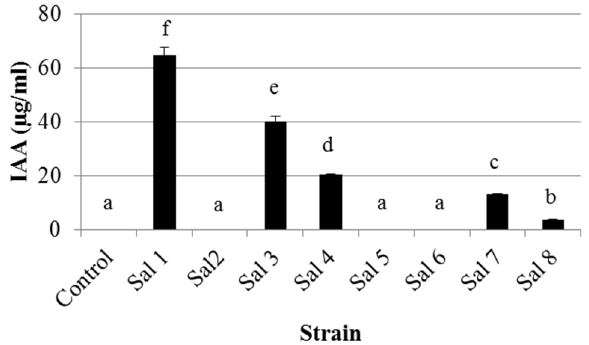
Figure 1. Indole-3-acetic acid (IAA) production by sweet potato endophytes in N + MR medium. The bars represent standard deviation ( n = 3) and different letters indicate significant differences at P < 0.01 by Tukey’s test.